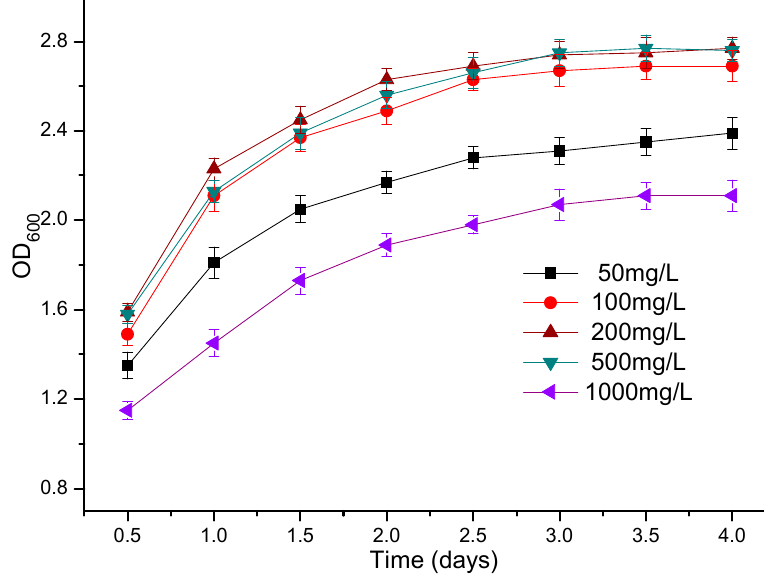
Figure 7. Effect of the concentration of atrazine on the growth of the strain ATLJ-11.